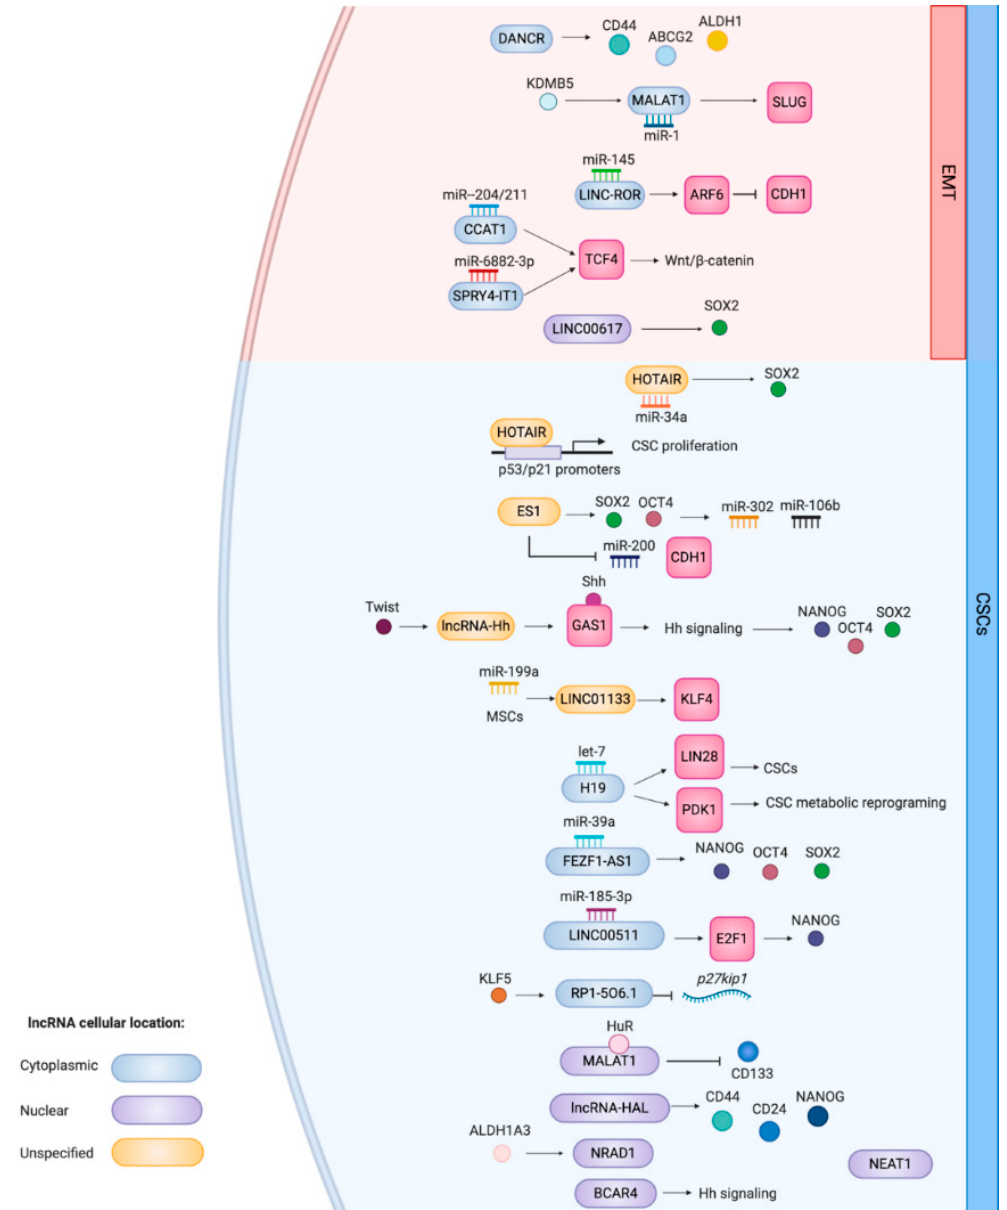
Figure 1. Schematic overview of the CSC and EMT-related functions of lncRNAs that have been associated with breast CSCs. This is a representation of functions summarized in Table 1. LncRNAs implicated with EMT genes and the processes are located in the red area of the cell. If known, the cellular localization of the lncRNA is indicated by the color coding. The figure was created with Biorender.com.